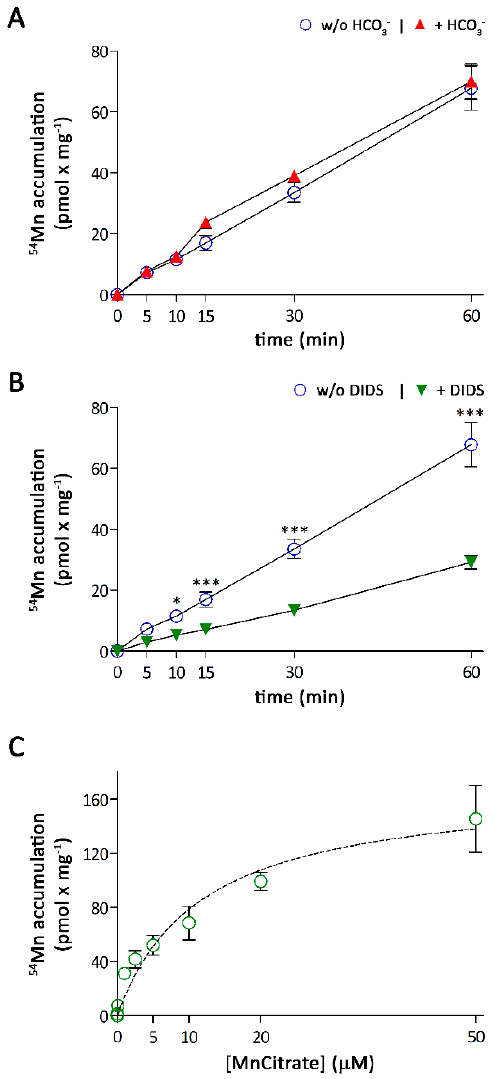
Figure 2. Characterization of 54 Mn accumulation by A549 cells. ( A ) Dependence of 54 Mn accumulation on exogenous HCO 3 − . ( B ) E ff ect of 1 mM 4,4-thiocyanostilbene-2,2-disulfonic acid (DIDS) on 54 Mn accumulation. ( C ) Concentration-dependence of 54 Mn accumulation. Data are presented as means ± SD from three independent experiments performed in duplicates. Statistical analysis was performed using ( A , B ) two-way ANOVA followed by the Bonferroni post-hoc test with * p < 0.05 and *** p < 0.001.